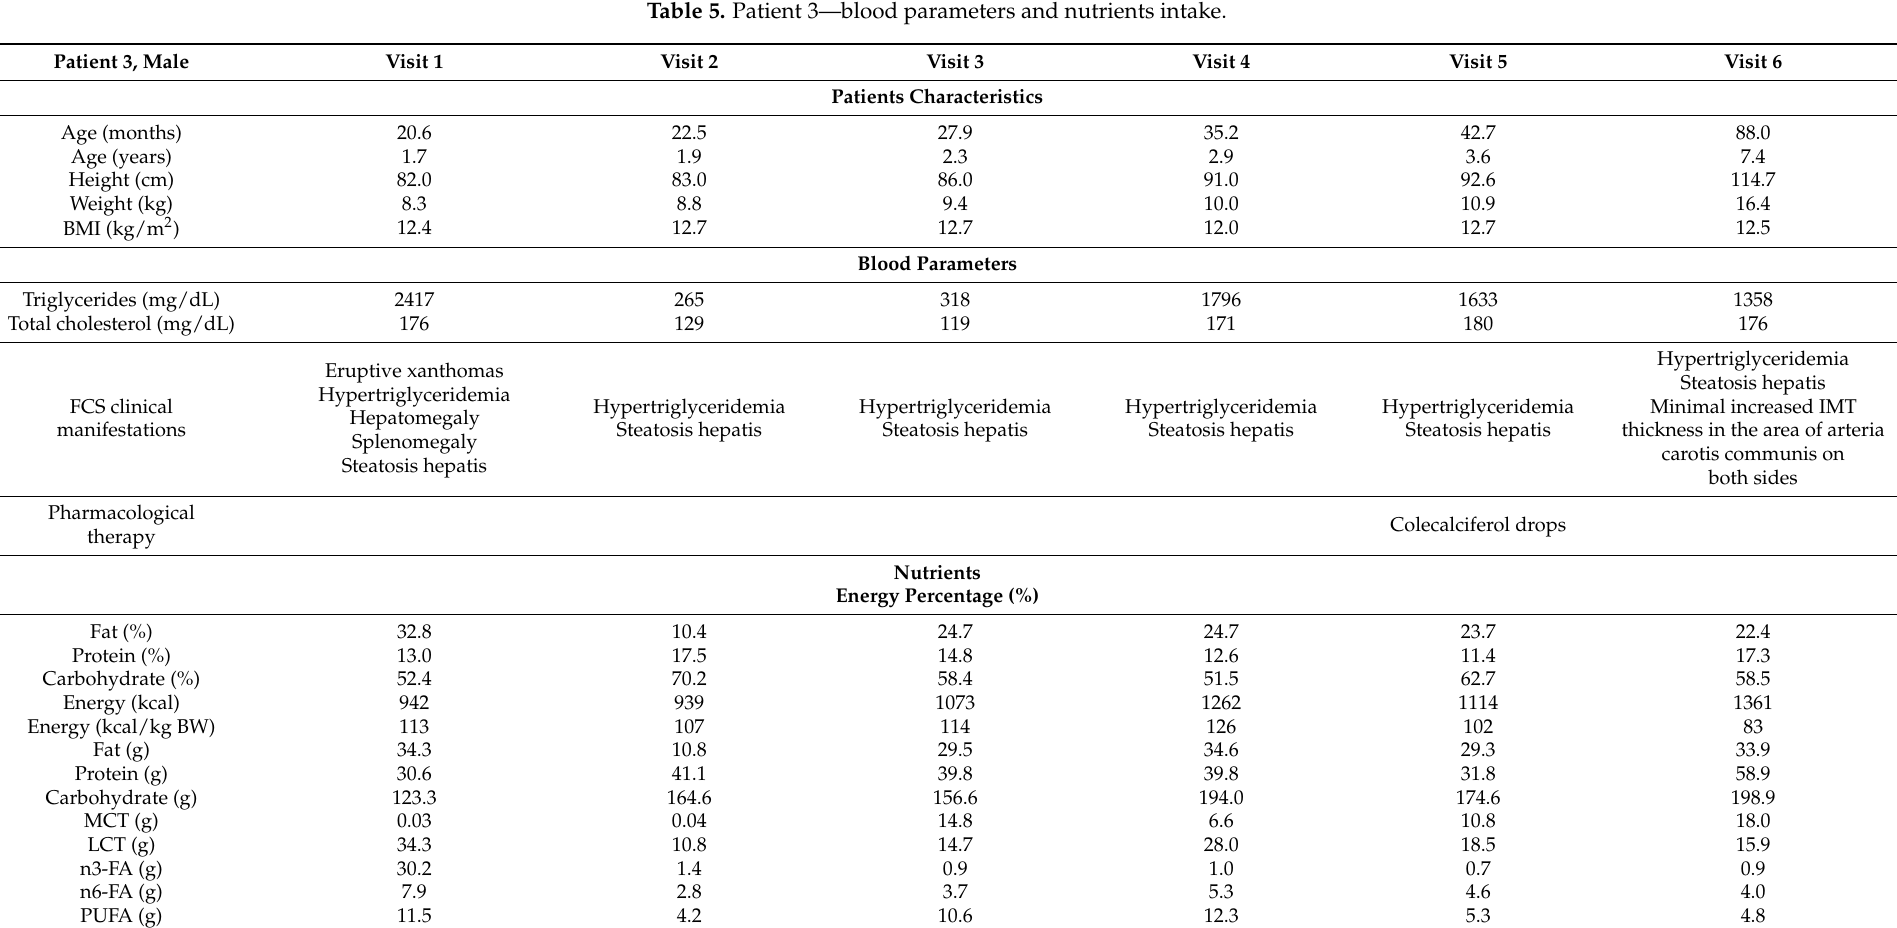
Table 5. Patient 3—blood parameters and nutrients